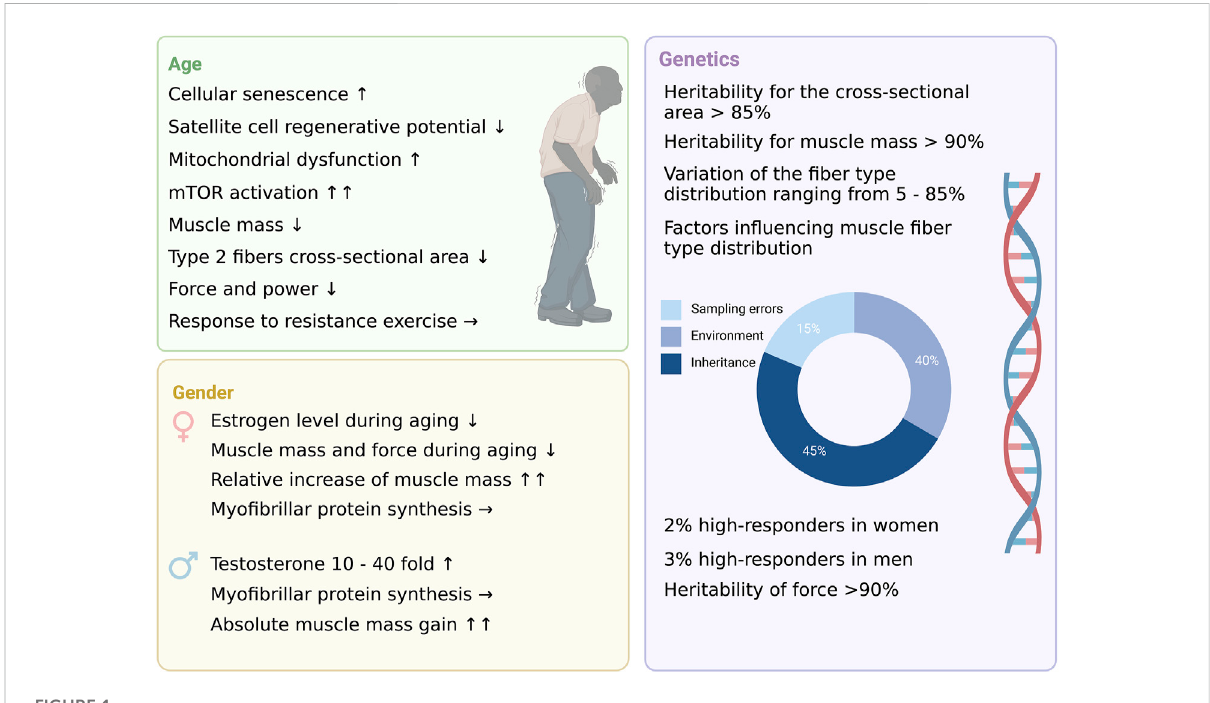
FIGURE 1 The three non-modi fi able factors of resistance